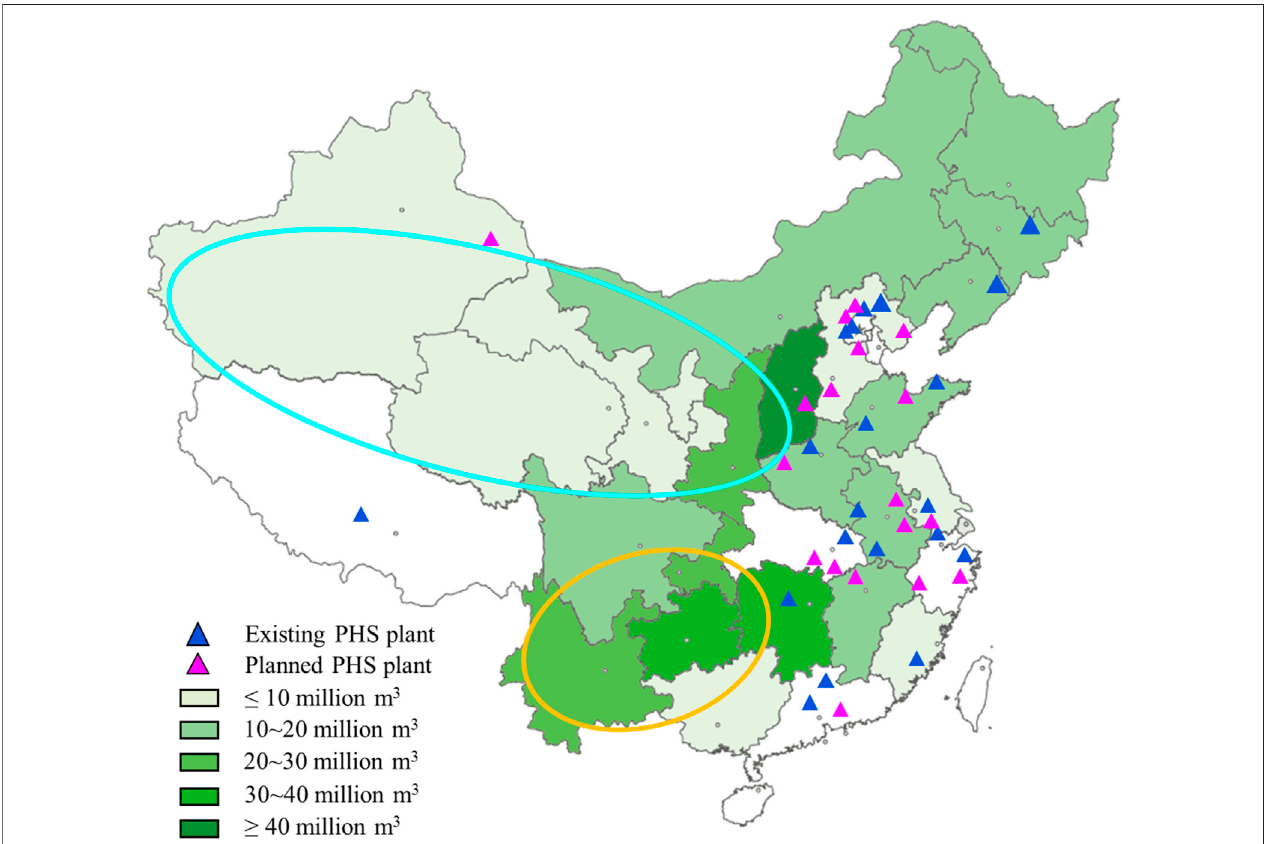
FIGURE 1 | Distribution of pumped hydro energy storage plants and underground space of the shutdown coal mines in Mainland China.